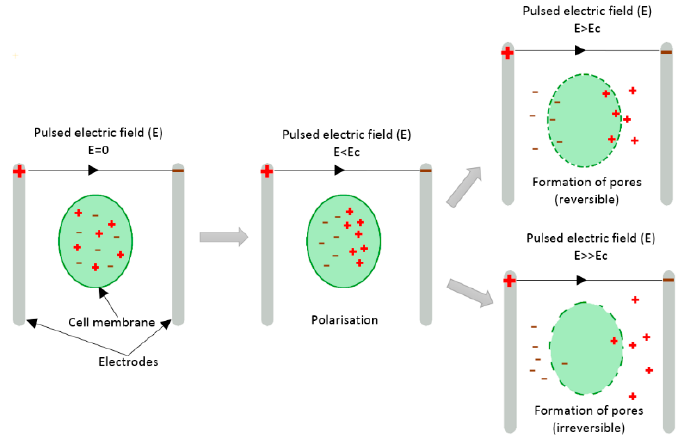
Figure 2. A biological cell exposed to an external electric field (polarization).